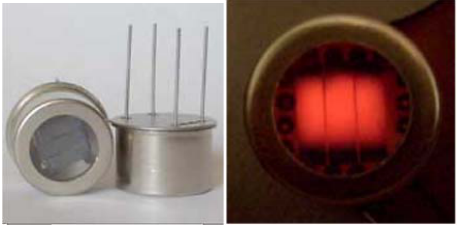
Figure 2. High ‐ emittance nichrome source EF8530 as a blackbody.